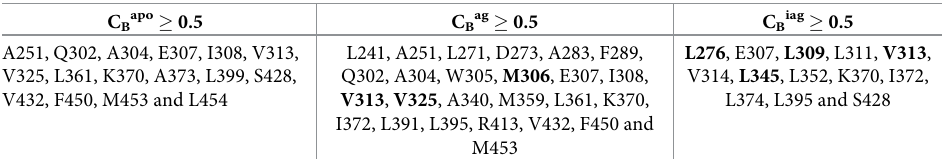
Table 4. Critical residues in ERR γ apo , ERR γ ag , and ERR γ iag with betweenness centrality values C B � 0.5. Residues involved in hydrophobic interactions are indicated in